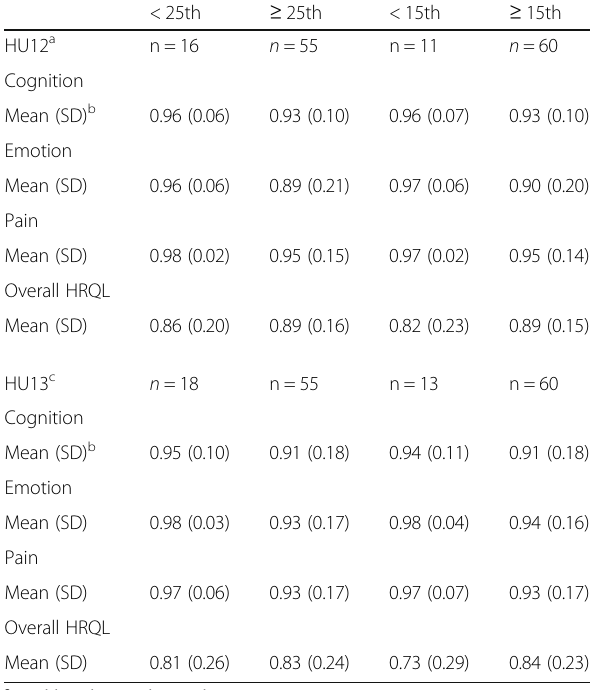
Table 2 Single attributes and overall health-related quality of life (HRQL) according to height